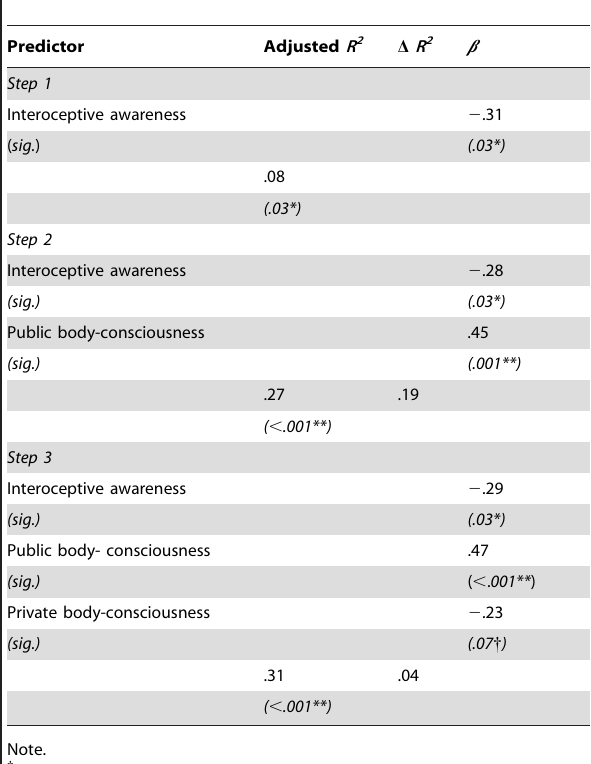
Table 3. Multiple Regression (Entry method) with self- objectification as the Dependent